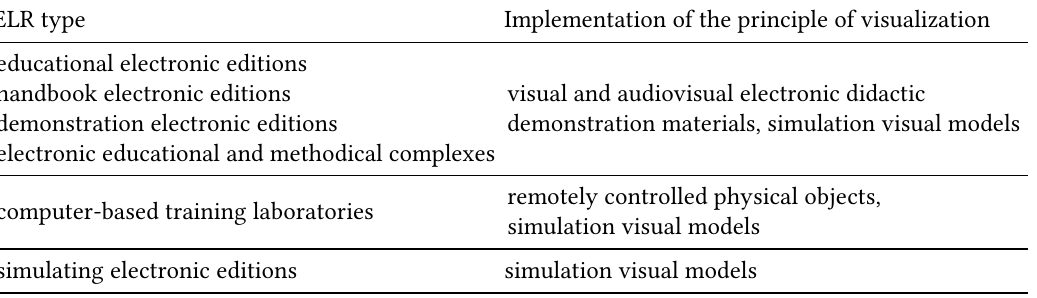
Table 1 ELRs for implementing the principle of visualization in the specialized chemistry